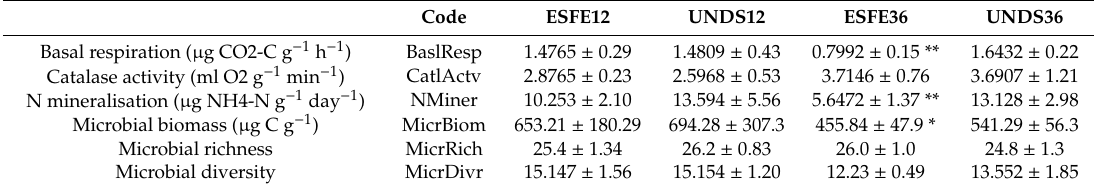
Table 6. Microbial community indicators associated with early successional forest ecosystem (ESFE) and windstorm undisturbed areas (UNDS) 12 and 36 months after event. Each data is an average of the individual plots and sampling date (mean ±